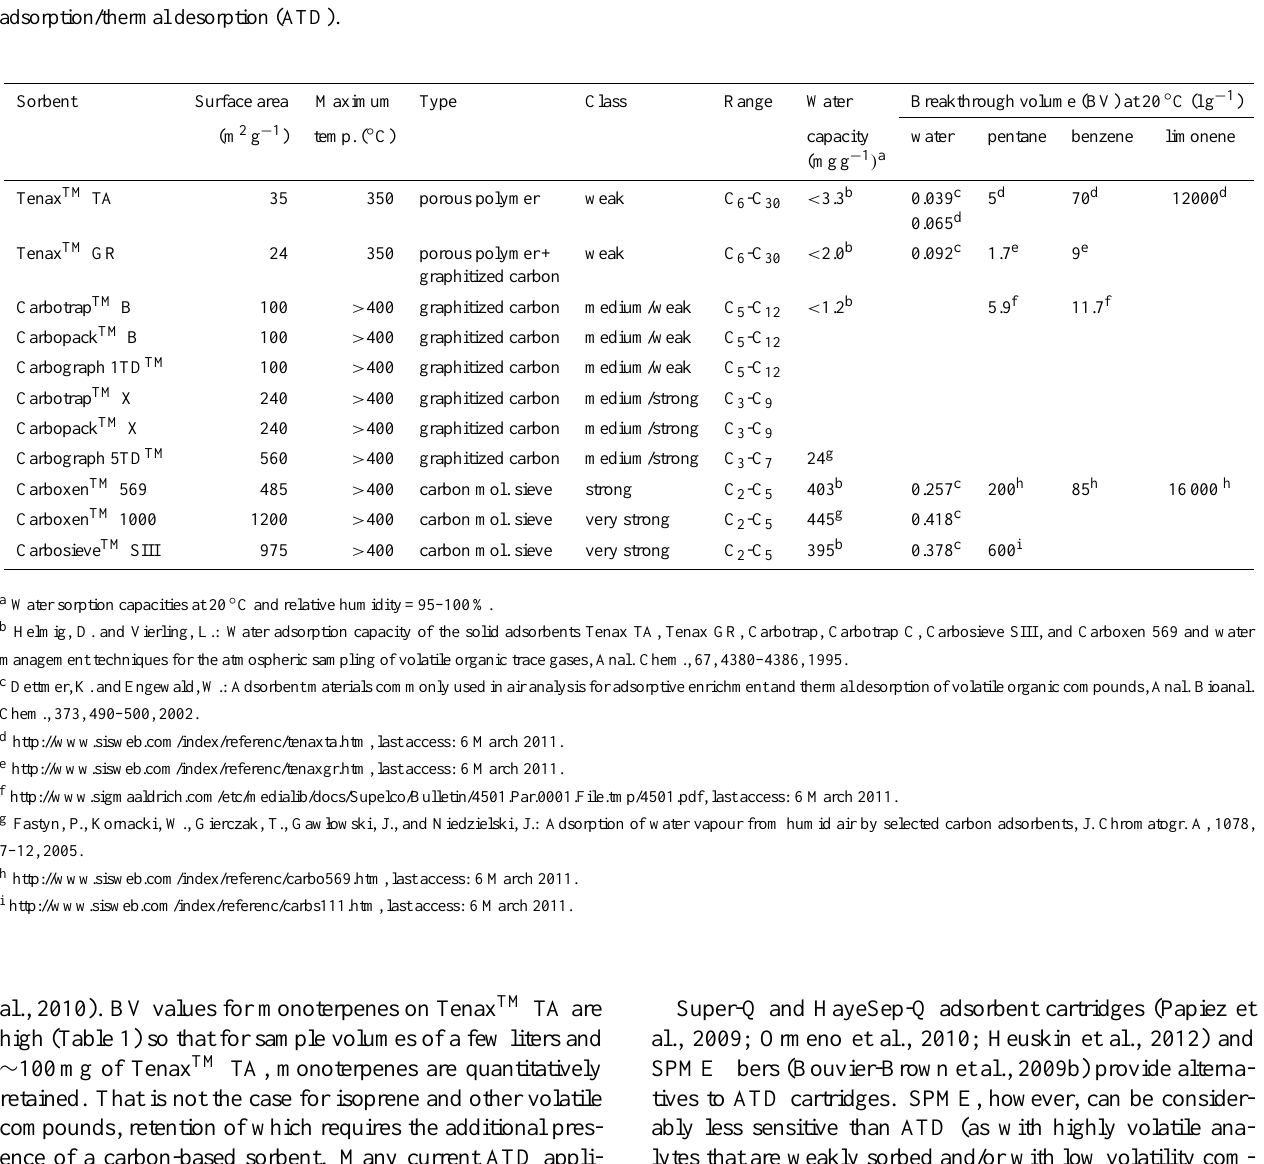
Table 1. Properties of adsorbent materials used in collection and analysis of volatilizable biogenic organic compounds (VBOCs) using adsorption/thermal desorption